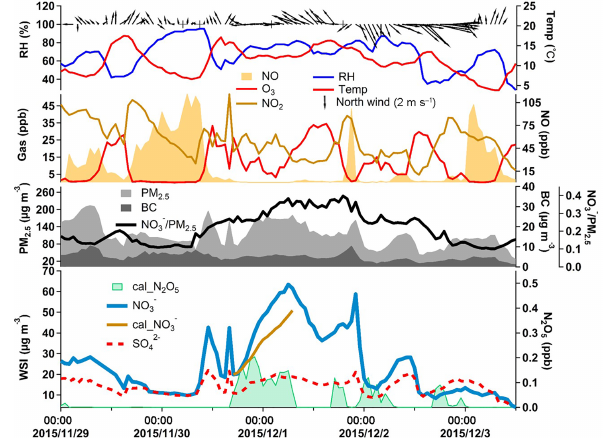
Figure 8. Time series of meteorological data and the concentrations of trace gases related to nitrate formation during 29 November to 3 December 2015. Cal_NO − represents the nitrate concentrations 3 calculated from the hydrolysis of N 2 O 5